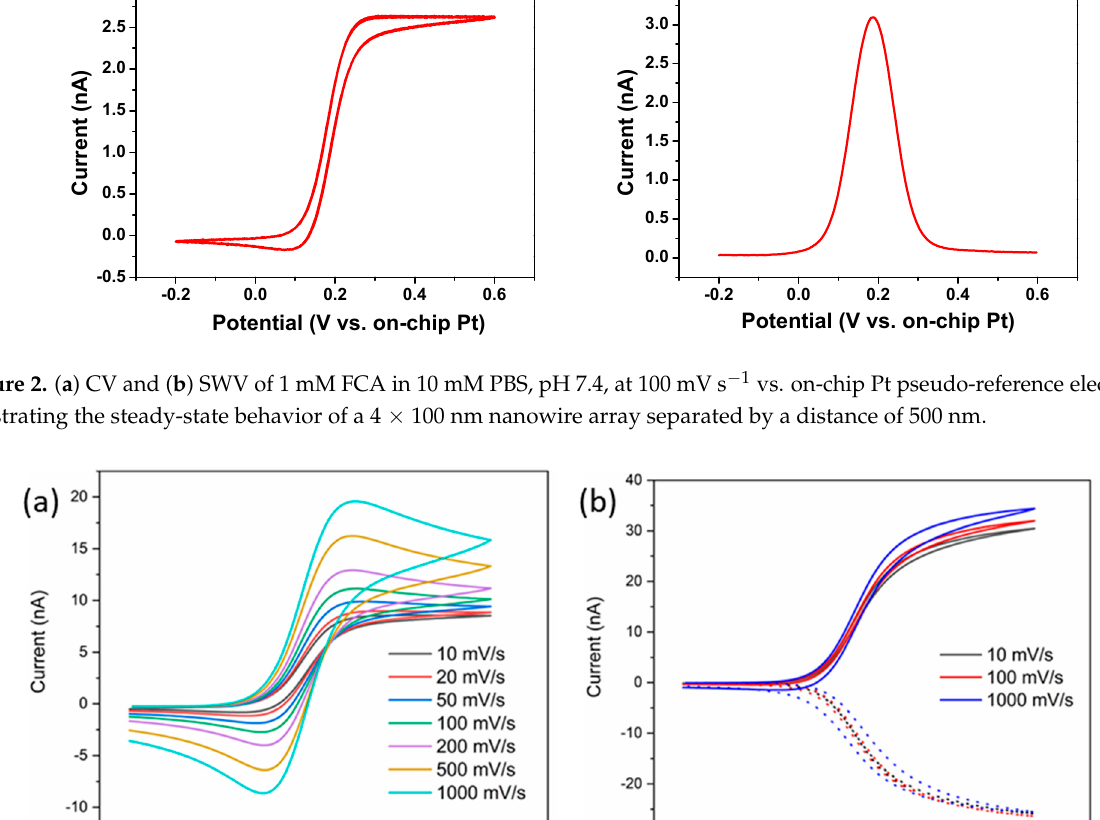
illustrating the steady-state behavior of a 4 × 100 nm nanowire array separated by a distance of 500 nm.